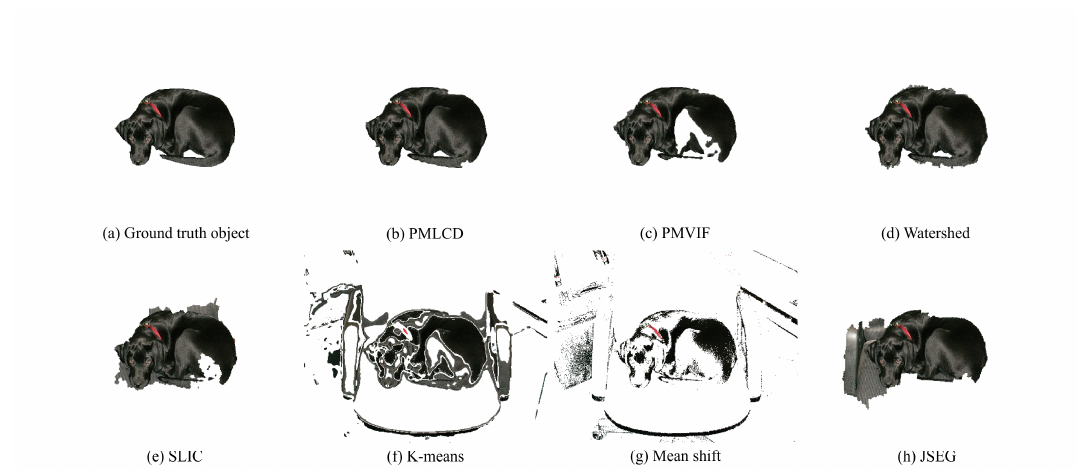
Figure 10. The ground truth object in Figure 9 and the corresponding segmented